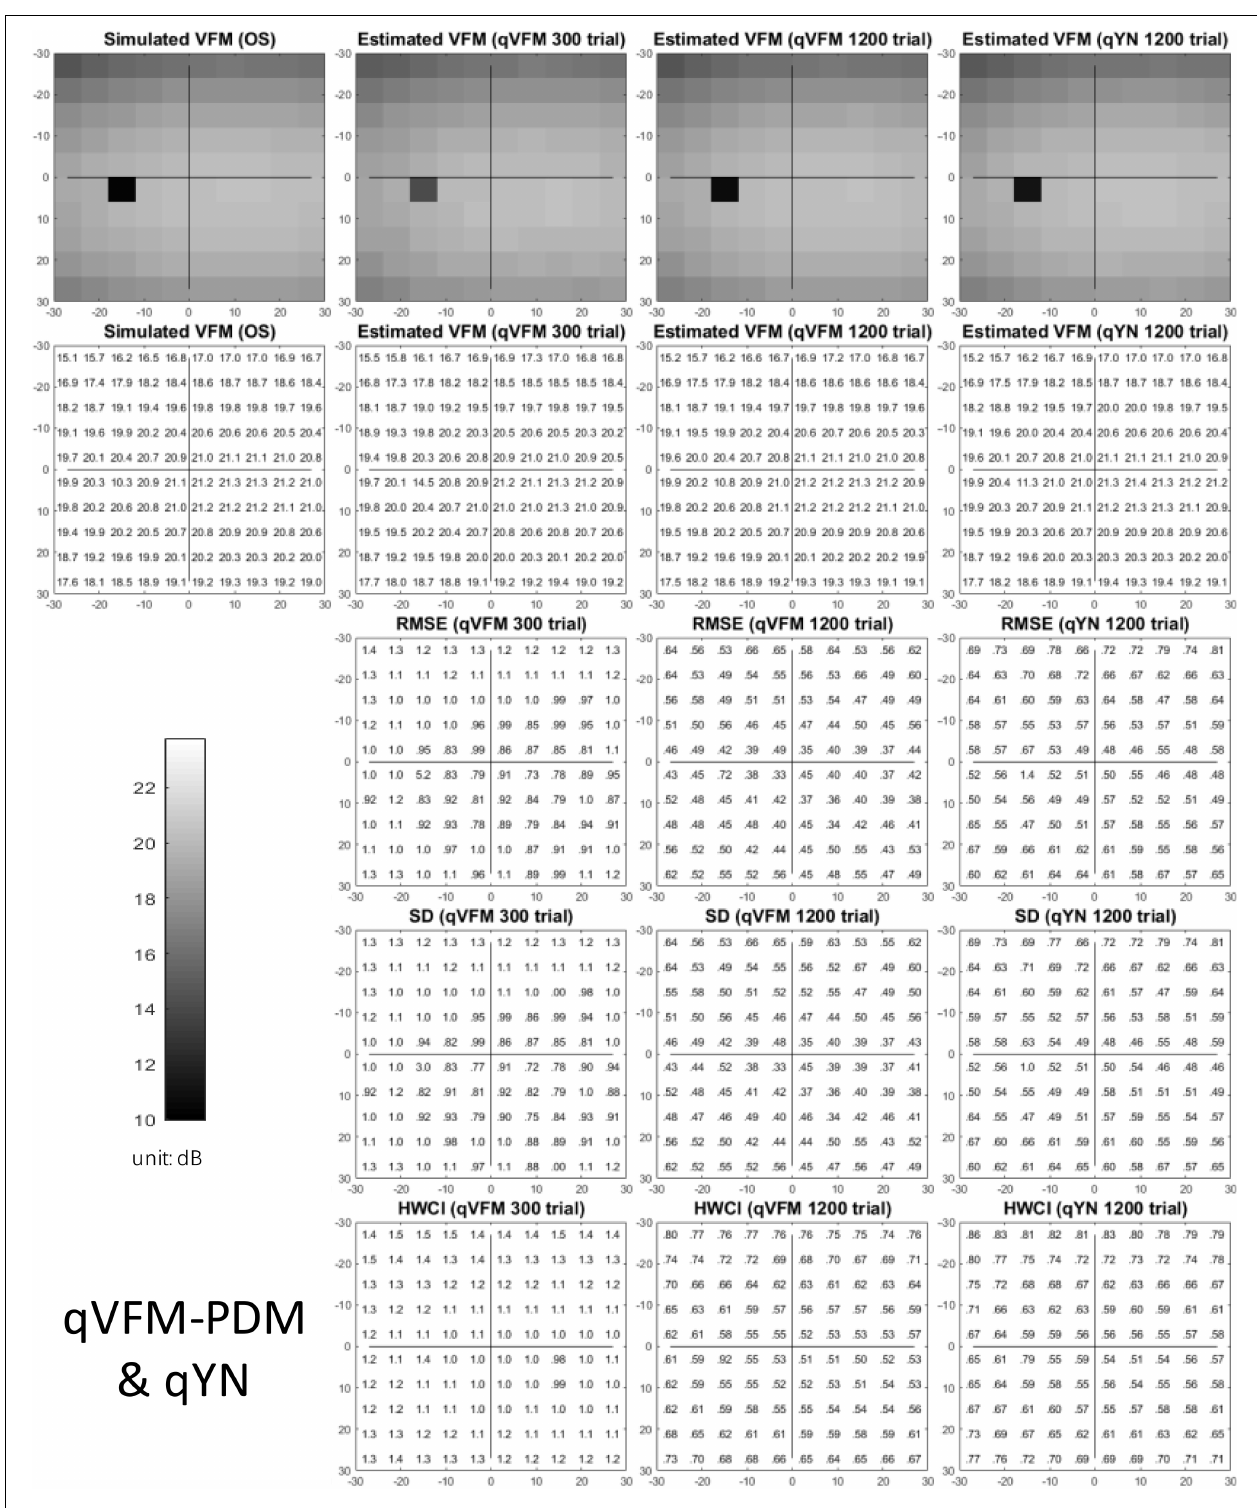
FIGURE 11 | Simulation results I of the cataract observer across 200 runs. The true VFM of the simulated observer (monocular) is presented in the first column of the first row with achromatic colormaps and second row with numerical values. The estimated VFMs obtained with the qVFM-PDM method after 300 trials and 1,200 trials, qYN method after 1,200 trials are presented in the first and second rows, respectively. The corresponding RMSE, SD, and 68.2% HWCI of the estimates are in the third, fourth, and fifth rows.